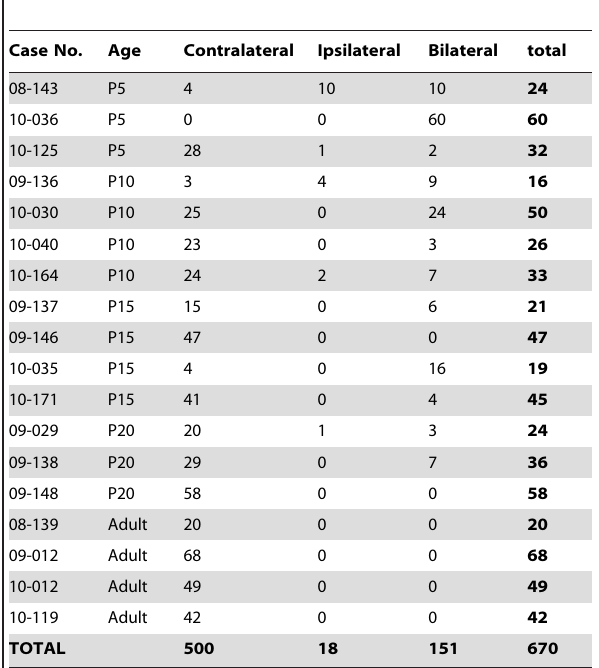
Table 6. Laterality of Receptive